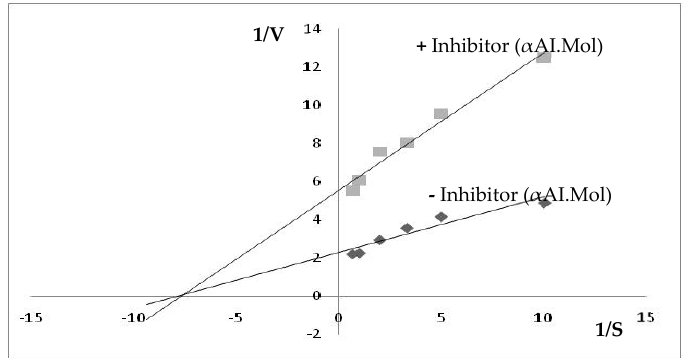
Figure 7. Lineweaver Burk curves: the hydrolysis rates (V) of pure starch (S) at various concentrations